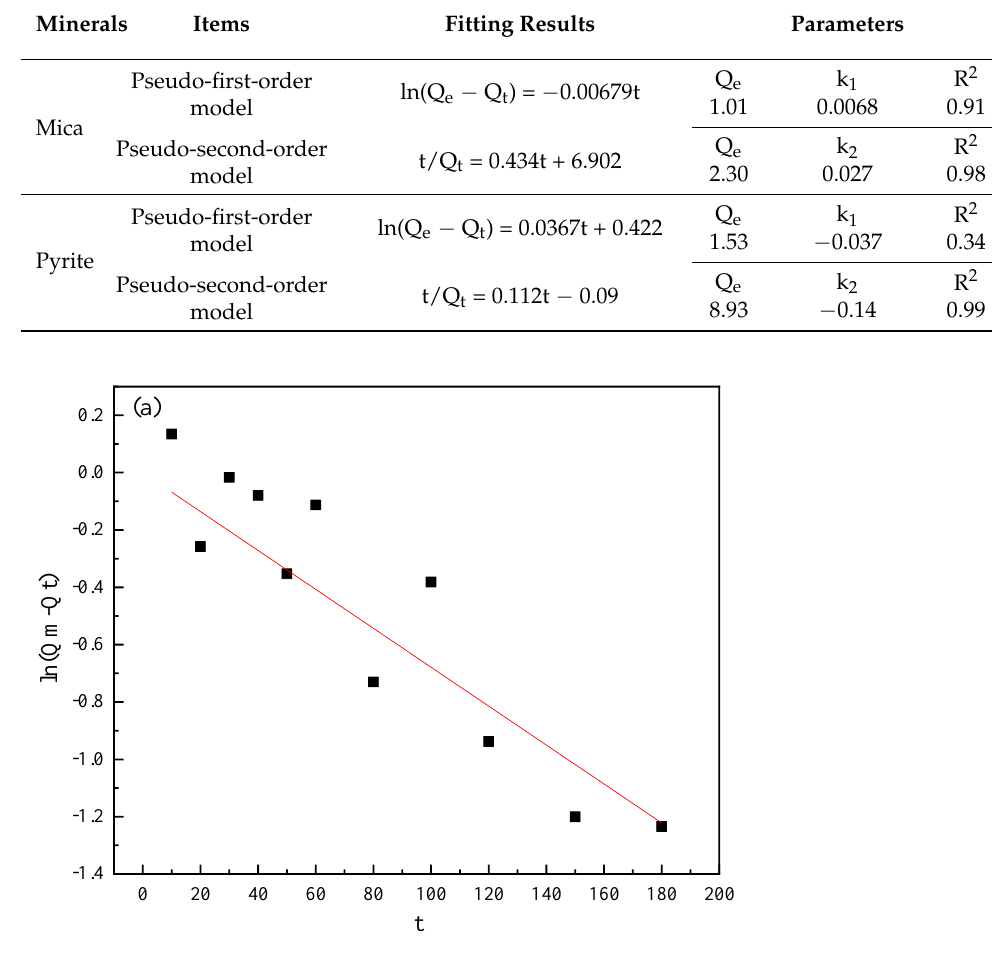
Table 2. Kinetic fitting results of thiourea adsorption on mica and pyrite.